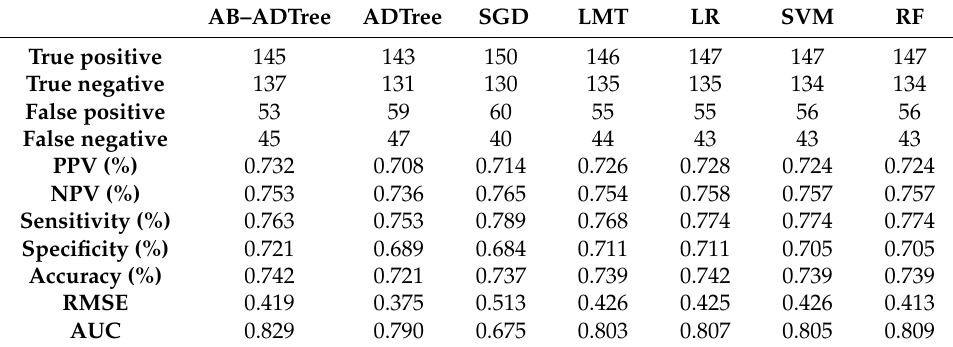
Table 5. GSPM Model validation using validation